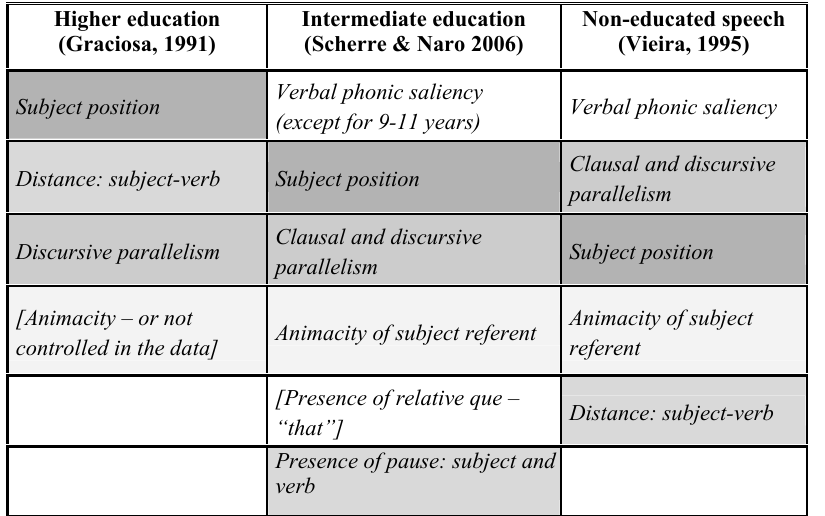
Table XXV: Relevant variables in studies of third person plural verbal agreement: Brazilian samples – different levels of